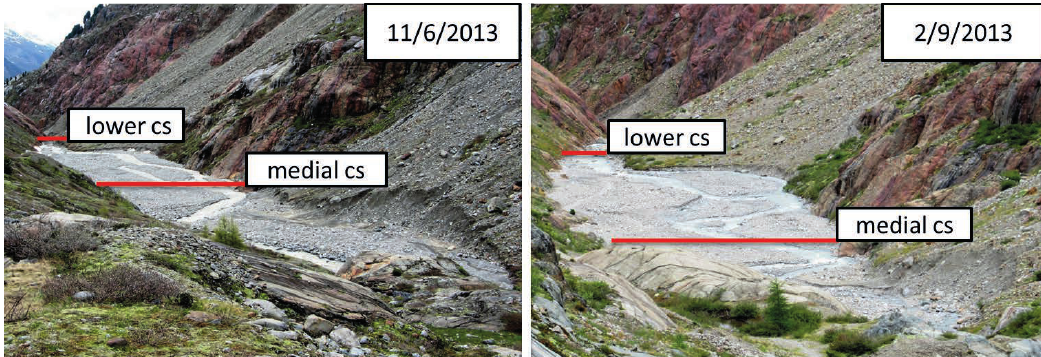
Fig. 3 Location of the cross - sections (cs) on the braid plain; left photo from 11/6/2013 with discharge 3.31m³ s -1 ; right photo from 2/9/2013 with discharge 2.87 m³ s -1 (view downstream). Discharge is measured at the TIWAG gauging station downstream, see Fig.